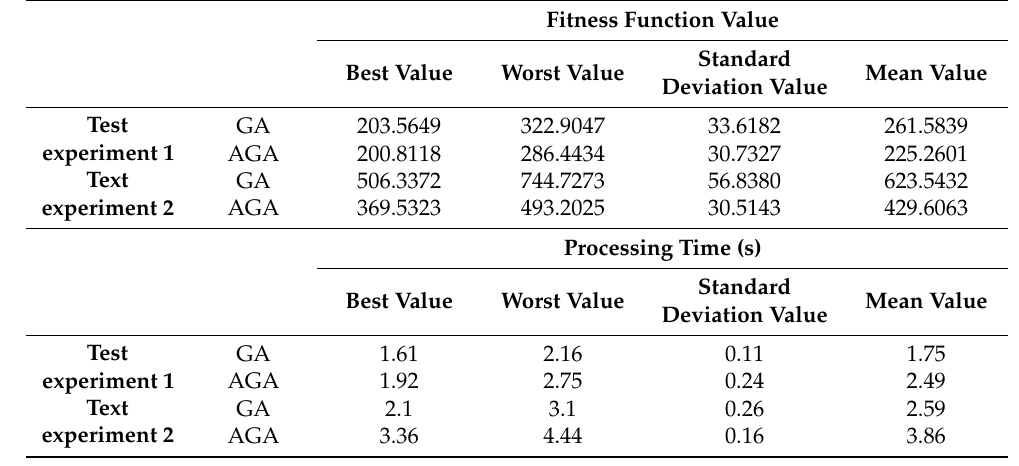
Table 5. Population evaluation indices comparisons of GA and